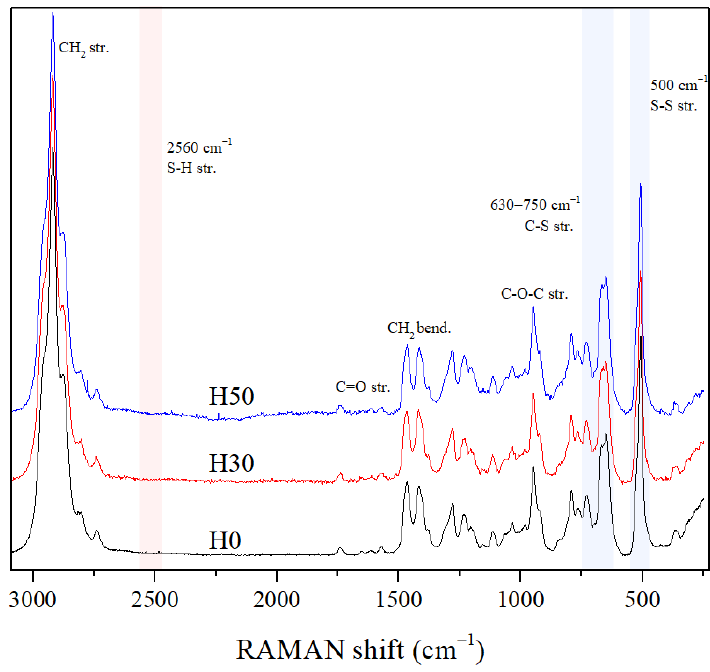
Figure 5. RAMAN spectra of H0, H30 and H50.